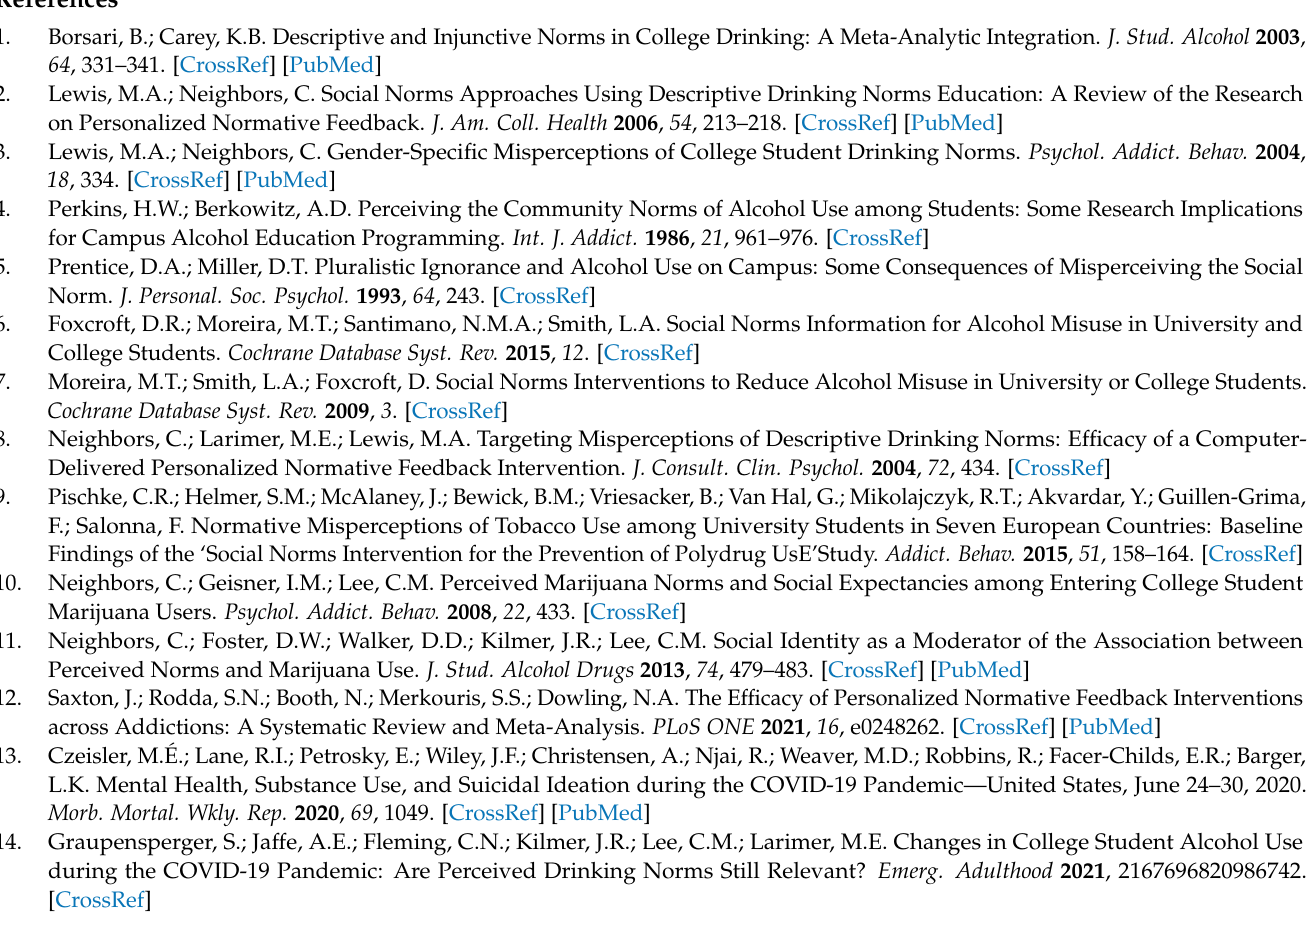
statistics; Table S3: Multivariable logistic regression models showing the association between over- estimation of substance use at one’s school and substance use, Healthy Minds Study,